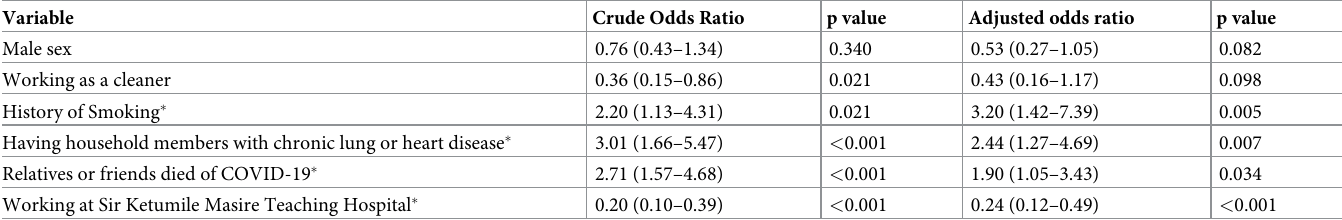
Table 7. Predictors of stress among frontline healthcare workers in Gaborone.